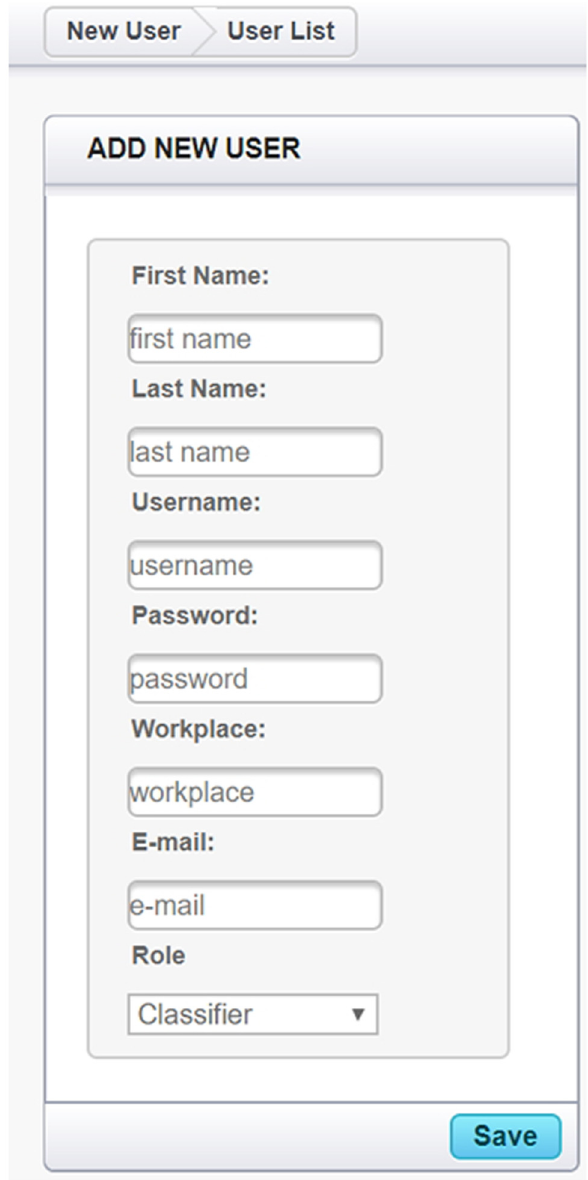
Figure 18: Interface of the Add New User